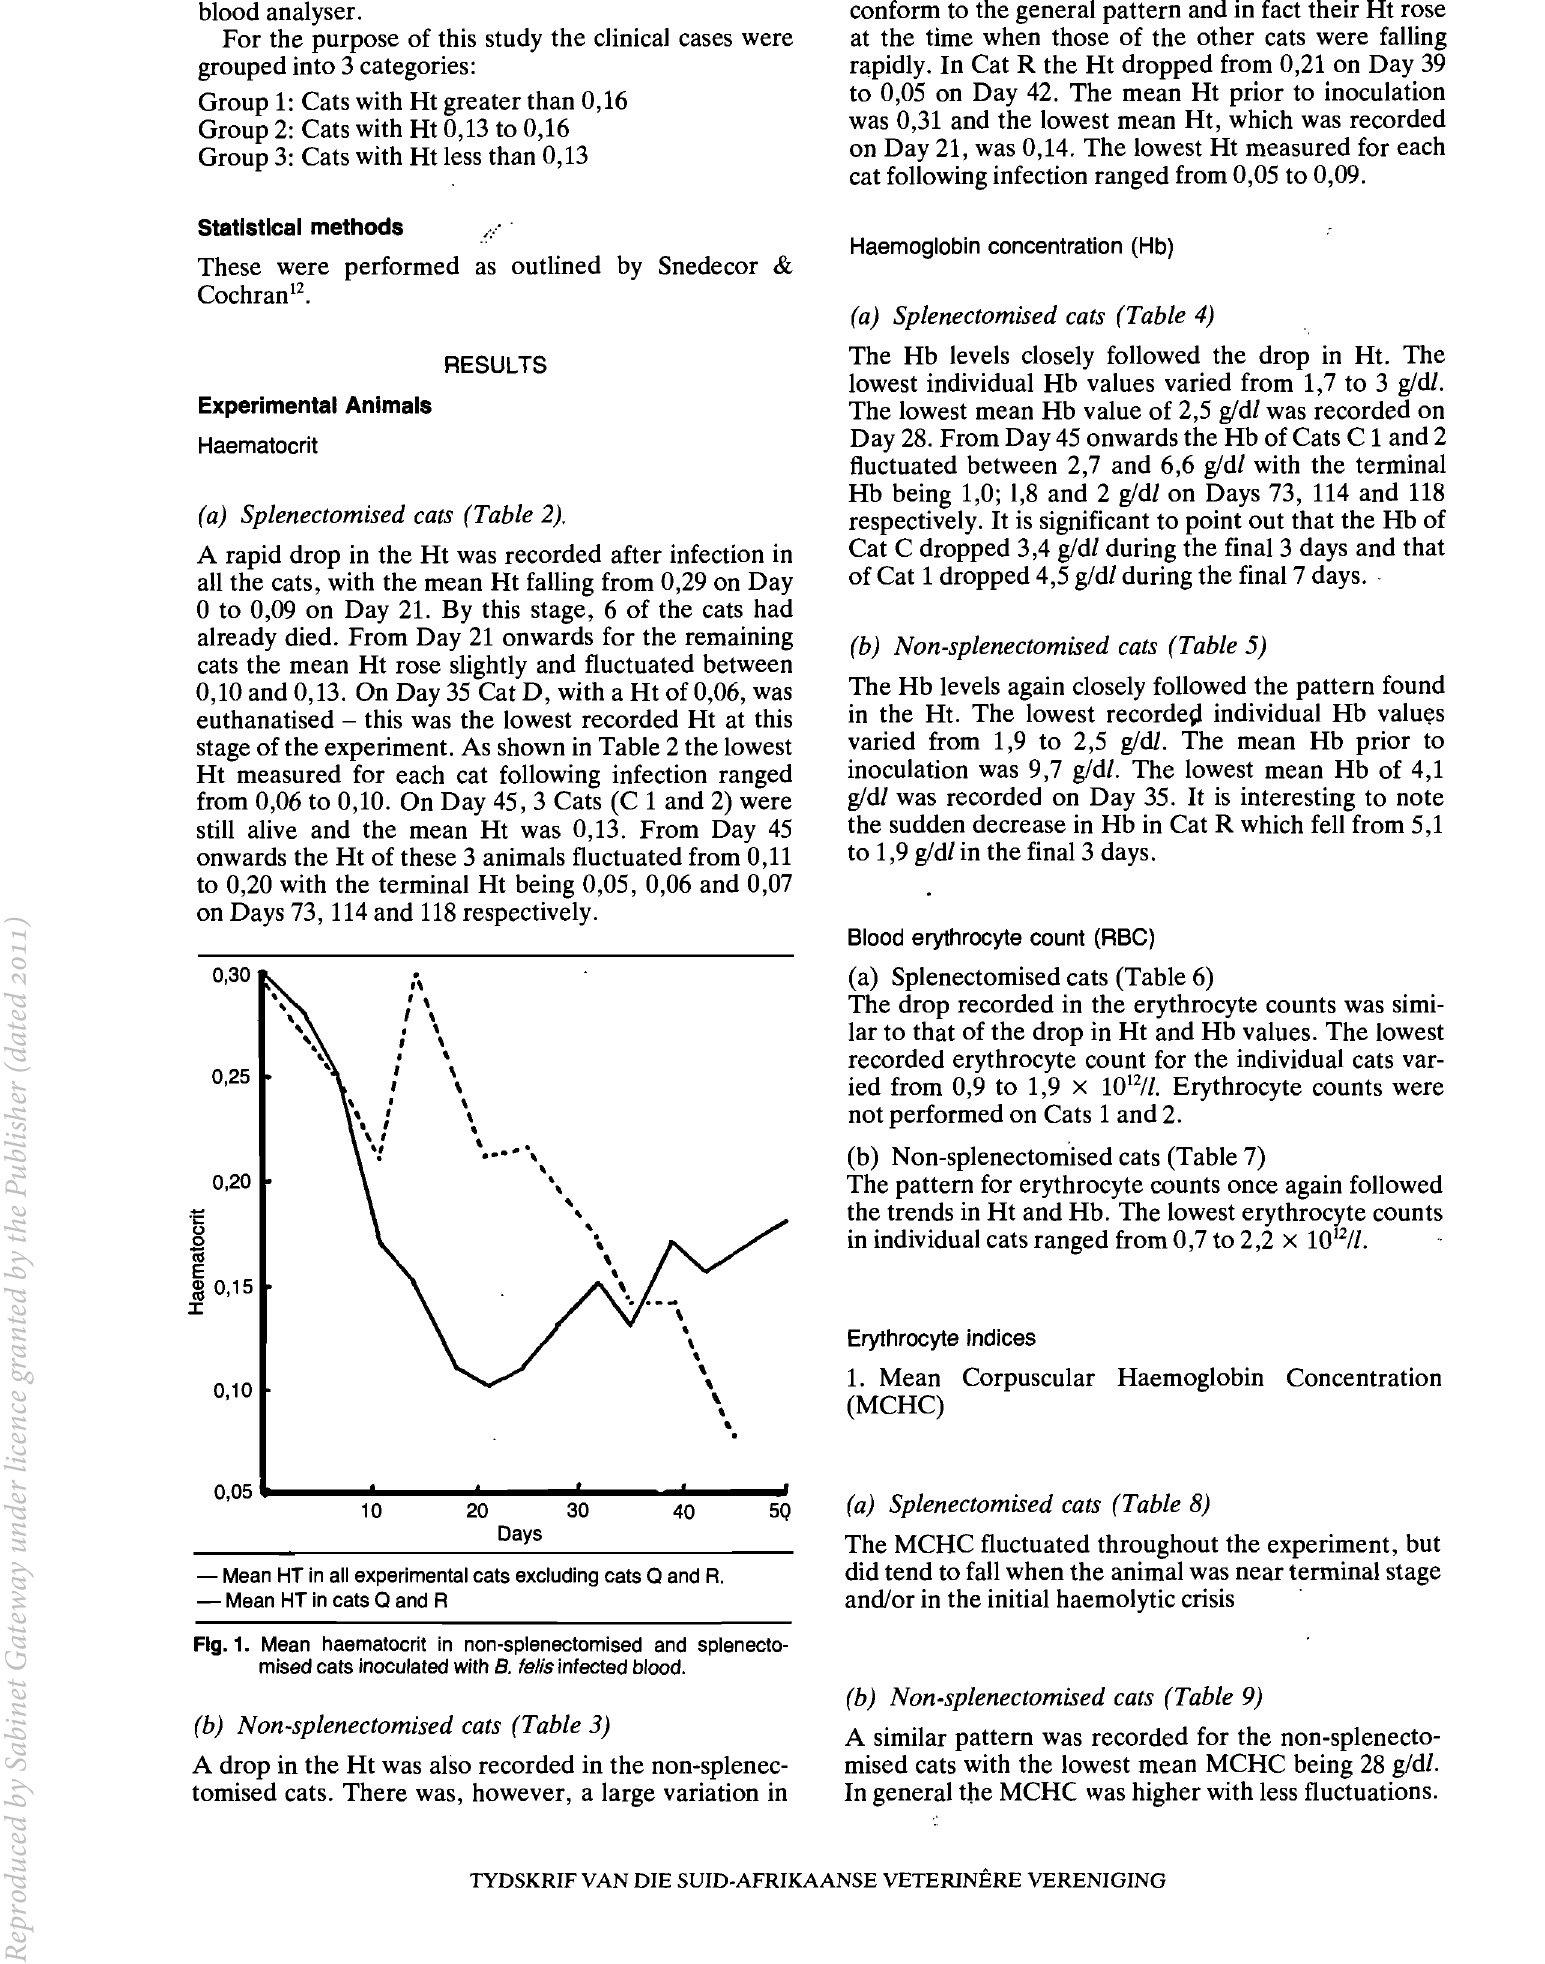
Fig. 1. Mean haematocrit in non-splenectomised and splenecto mised cats inoculated with B. fe/is infected blood. (b) Non-splenectomised cats (Table 3)